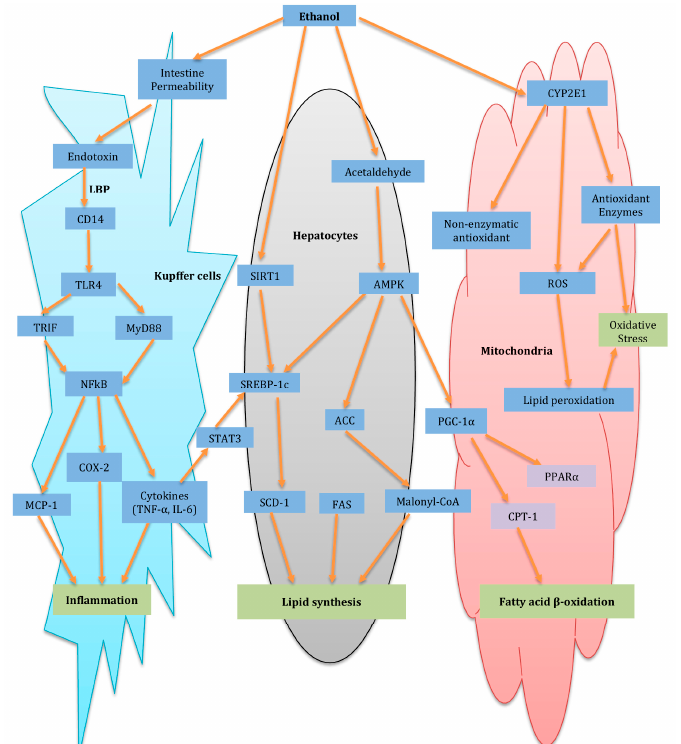
Figure 1. Schematic diagram of major pathways of alcoholic fatty liver (ALD) and potential molecular targets of herbal medicine for the protection of ALD. The arrows indicate the potential molecular targets involved in the development of ALD and regulated by herbal medicines. ACC: Acetyl-CoA carboxylase; AMPK: AMP-activated protein kinase; CD14: cluster of differentiation 14